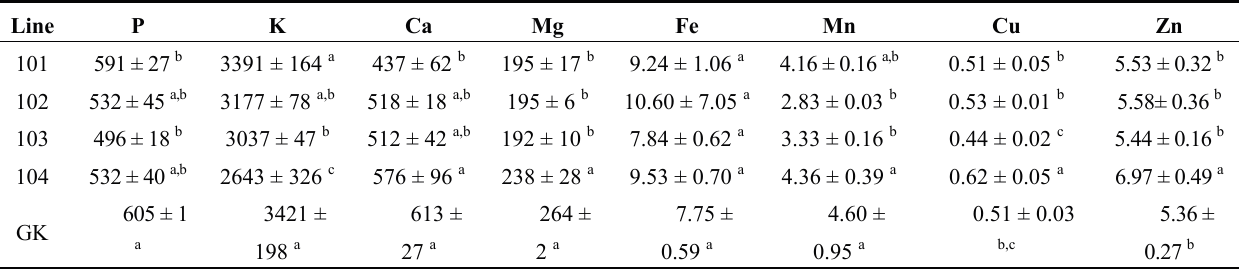
Table 3. Mineral content of broccoli